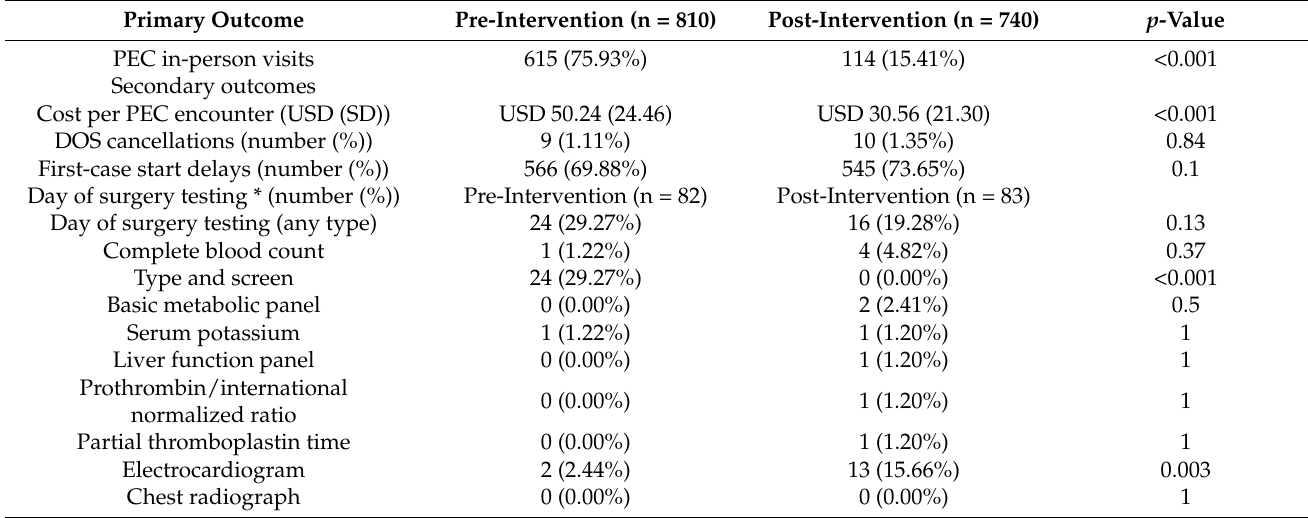
Table 2. Comparison of outcome measurements between groups.